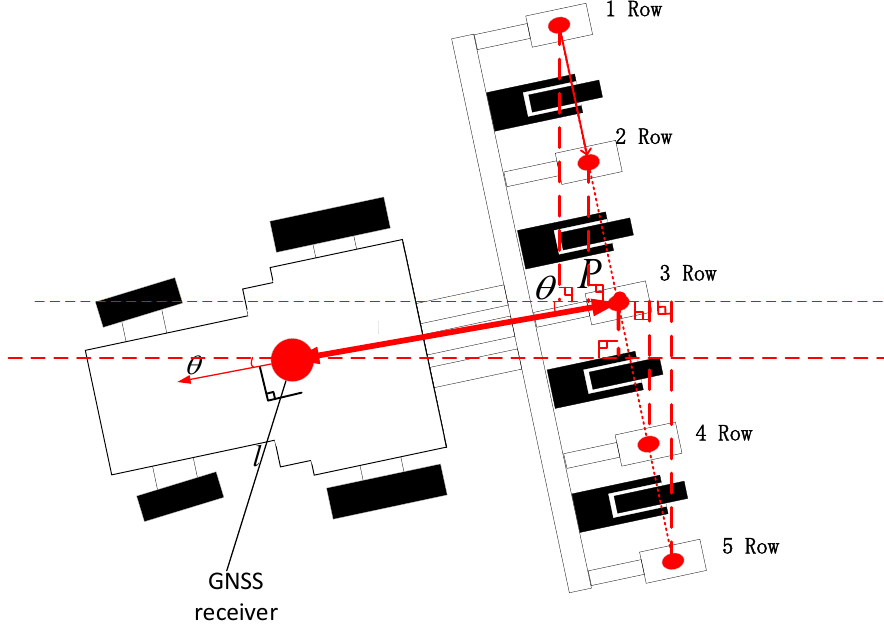
Figure 6. Calculation of Seeding Unit Position.